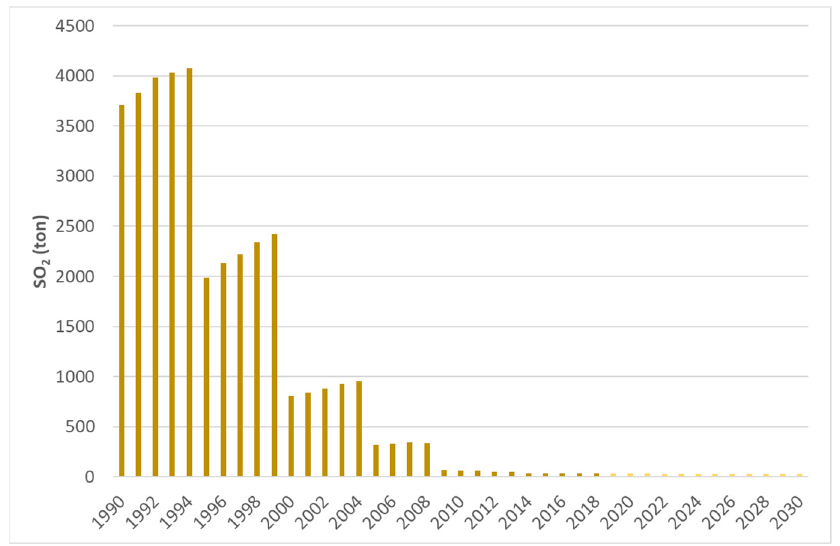
Figure 13. Total SO 2 emissions from passenger cars in Greece for the period 1990–2030.